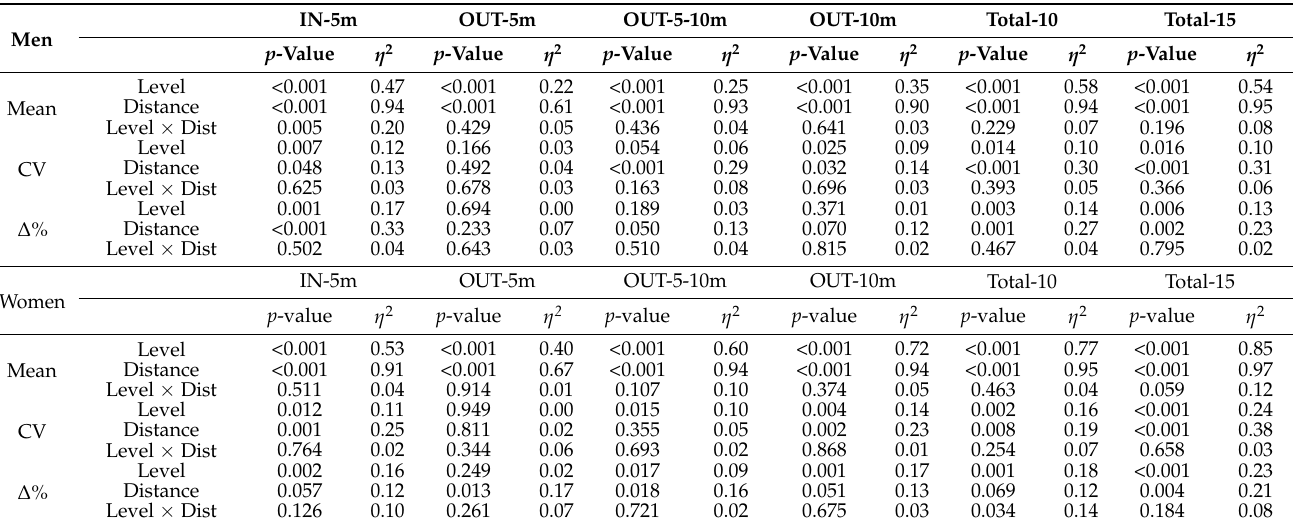
Table 2. Comparison of means, coefficients of variation (CVs), and relative changes in performance ( ∆ %) by a 2-way ANOVA: performance level (heat vs. final) × race distance (100 m vs. 200 m vs. 400 m vs. 800/1500 m) and corresponding effect size ( η 2 ). The eight finalists were compared with the eight fastest but non-qualified swimmers from the heats for each